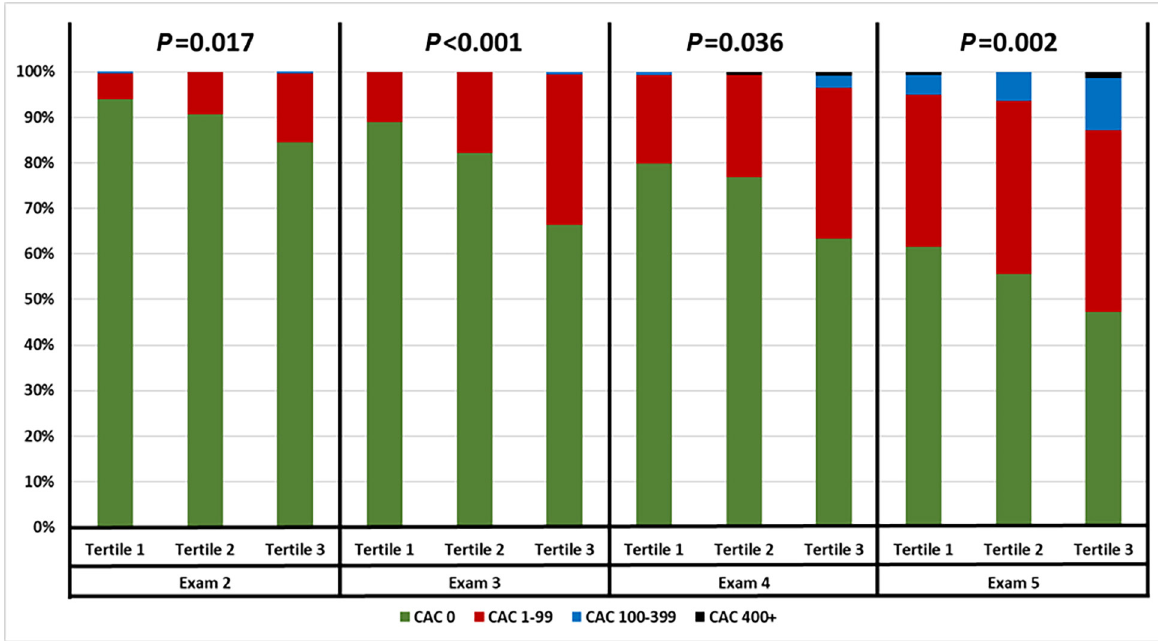
Figure 3. Coronary artery calcium score progression stratified by sTNFR-1